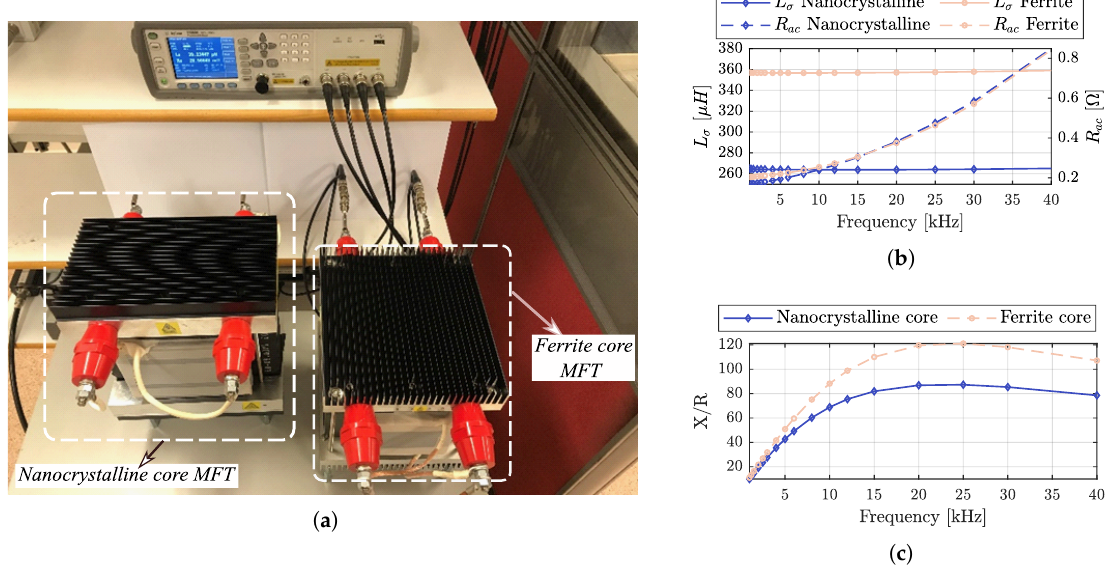
Figure 12. ( a ) Test setup for measuring the leakage inductance and the ac resistance of two MFTs. ( b